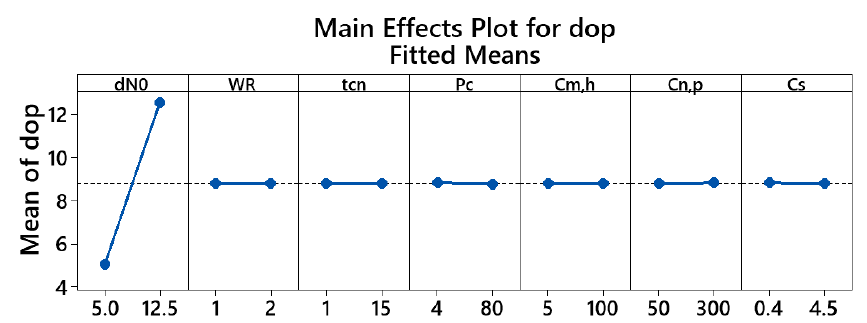
ff ects plot for optimum initial nozzle Figure 6. Main effects plot for optimum initial nozzle diameter. Figure 6. Main e